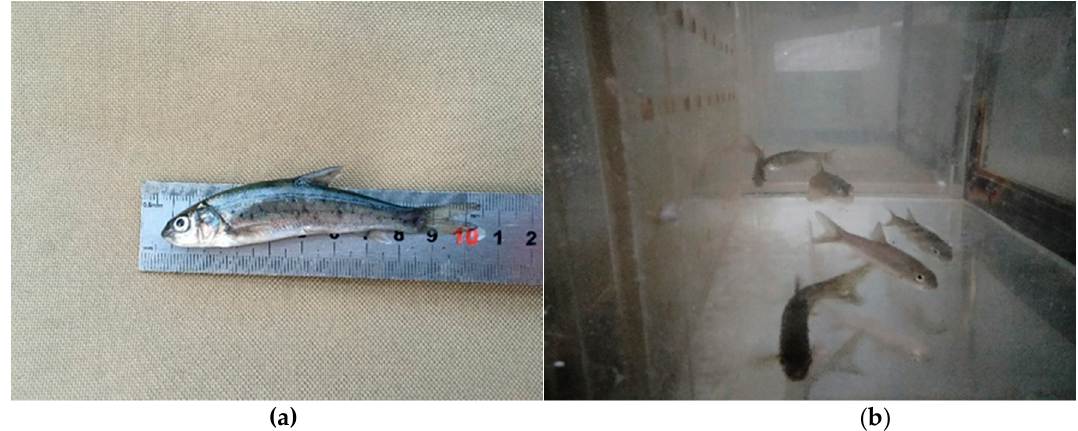
Figure 2. Picture of Prenant’s Schizothoracins used in the present experiment. ( a ) is a dead fish in the experiment, and ( b ) is fish in total dissolved gas (TDG) supersaturated water.